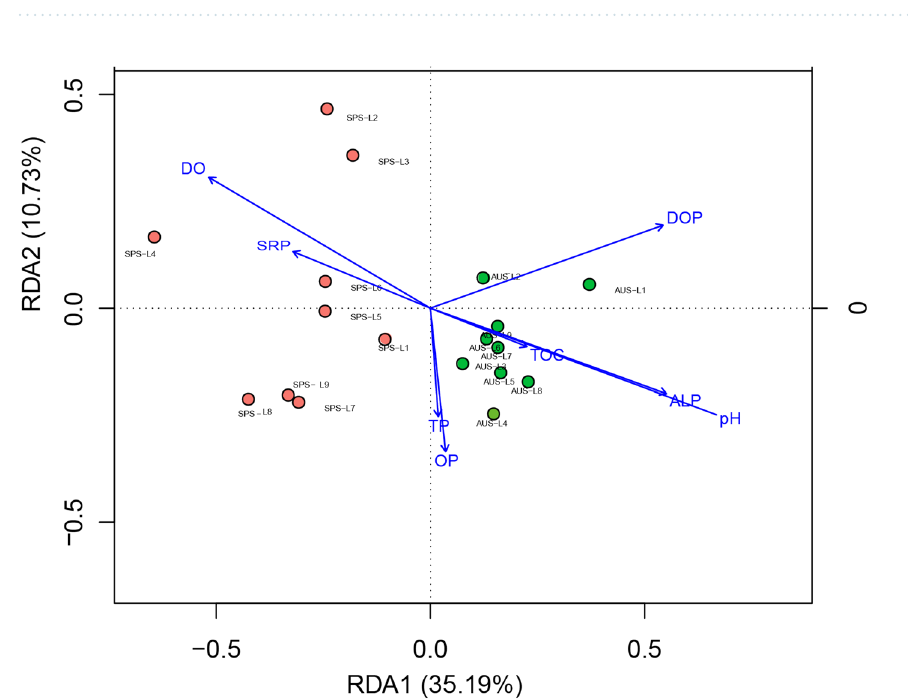
Figure 7. The RDA analysis of phoD -harboring bacterial genera and physico-chemical factors in the sediments of Sancha Lake in the spring and autumn. SPS Spring Location, AUS Autumn